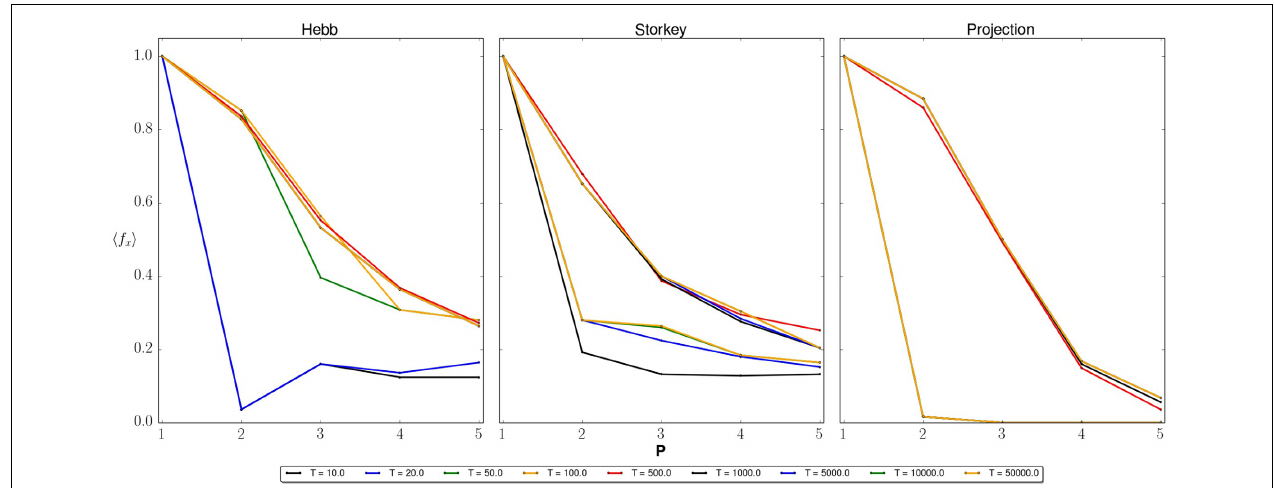
FIGURE 11 | Average probability to recall the correct memory with respect to number of input patterns for n = 5 neurons. Each panel plots recall success with respect to the number of stored patterns p = 1 , 2 , 3 , 4, and 5 for a different learning rule and applied bias (Hebb, (cid:6) = 0 . 5; Storkey (cid:6) = 0 . 15; projection, (cid:6) = 0 . 15). Each line corresponds to a different annealing